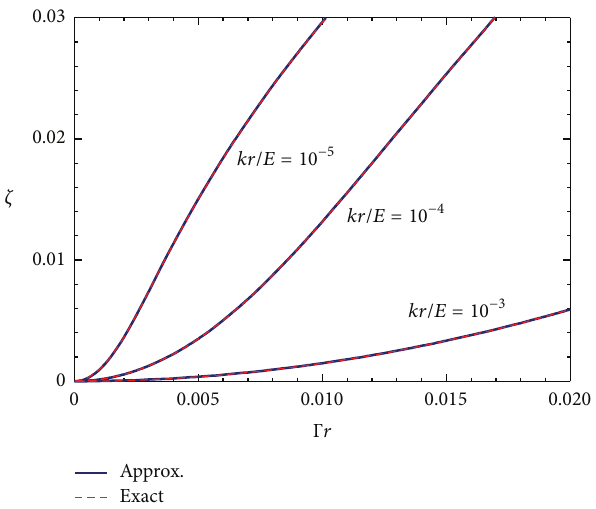
Figure 10: Data comparison between the approximated oblateness 𝑘 . 𝜁 and the exact one 𝜁 𝑢 for different values of